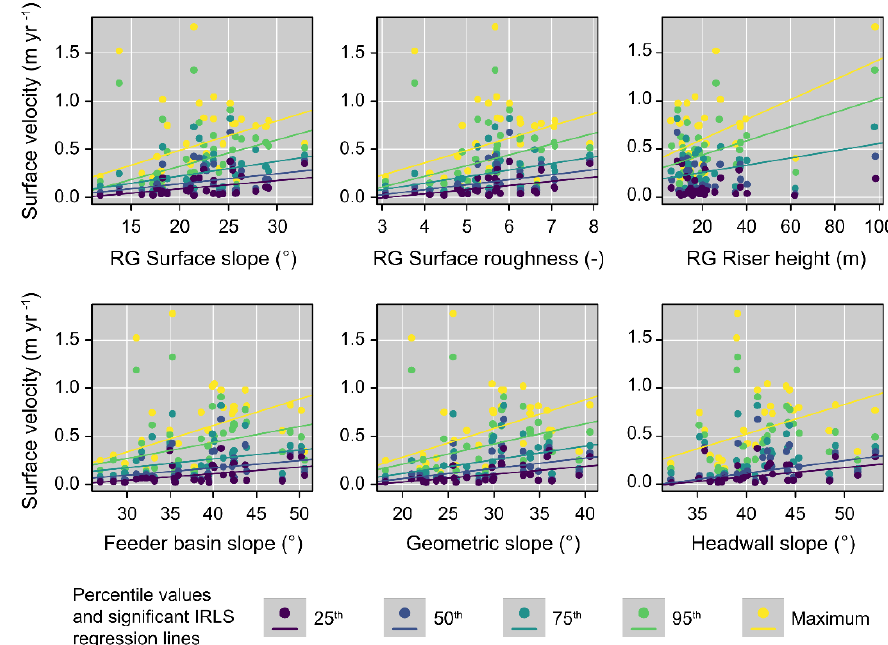
Figure 6. Scatterplots of horizontal surface velocities versus selected candidate parameters derived for individual rock glaciers and their contributing areas. Colour coded points represent velocity percentiles for each individual active rock glacier (n = 30), solid lines show significant ( p ≤ 0.05) iteratively reweighted least squares (IRLS) regression lines.